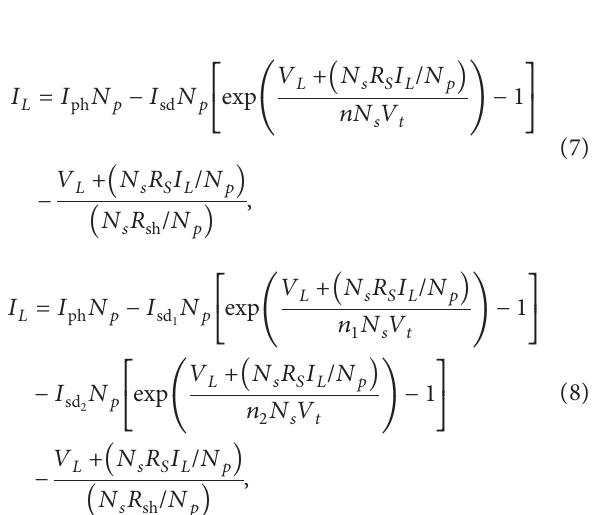
Figure 3: Equivalent circuit diagram of